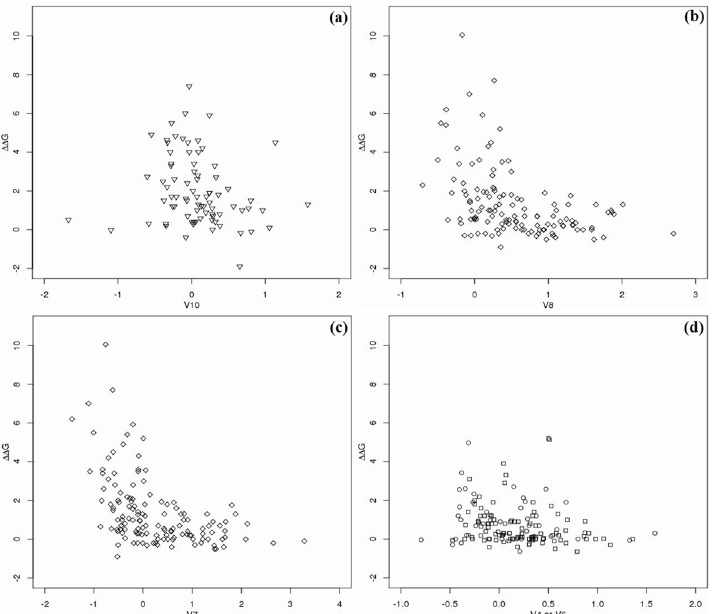
Fig 5. The distribution of B r for the fourth amino acid group (in (a)), and for the third group (in (b)), dif for the third group (in (c)). The y- and for the fi rst and second groups (in (d)), and the distribution of B r avg axes denote ΔΔ G . (cid:7) : ILE, VAL, LEU, MET, ALA and GLY; ◻ : CYS, THR, SER, PRO, HIS, GLN and ASN; ♢ : GLU, ASP, LYS and ARG; ! : PHE, TRP and TYR. The importance of V10, V8 and V7 is ranked as 9 th , 19 th and 24 th , respectively, as shown in Fig 2, while the Pearson correlation coef fi cients of the three features are -0.054, -0.213 and -0.313, respectively, as shown in Table 5. V4 and V6 are not in the top 40 important features in